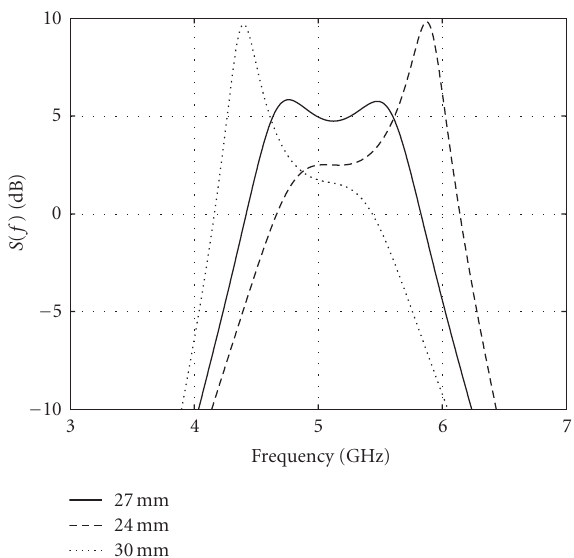
Figure 8: Radiation patterns at the lower end frequency (4.5GHz) of the operating bandwidth in the E- and H-plane.